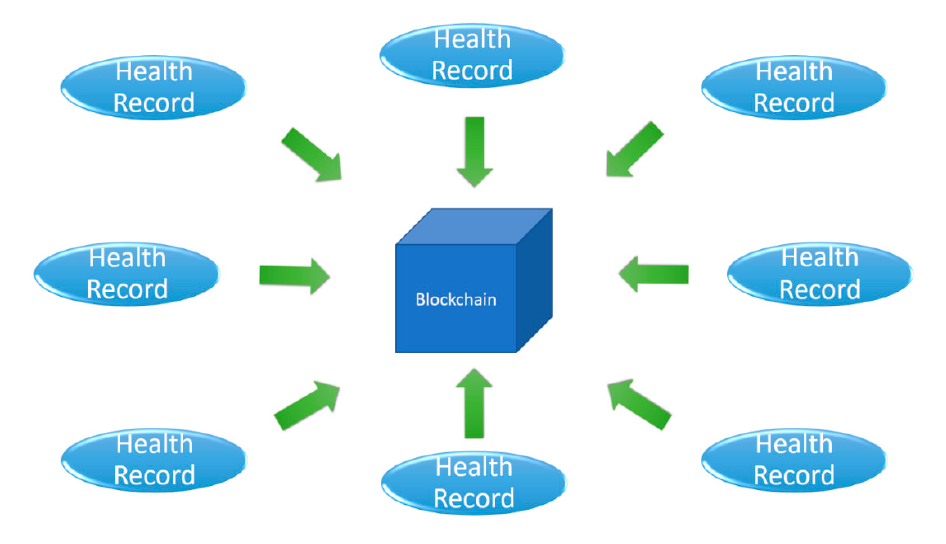
Figure 7. Example of distributed oracles.